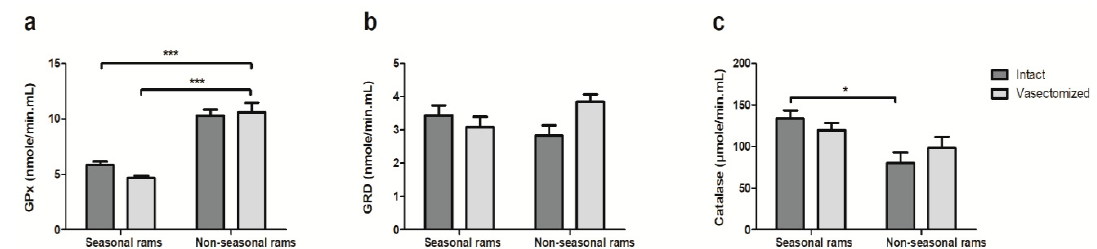
Figure 4. ( a ) Glutathione peroxidase (GPx), ( b ) glutathione reductase (GRD) and ( c ) catalase enzymatic activity in seminal plasma of intact and vasectomized rams subjected to temperate (seasonal) or equatorial (non-seasonal rams) photoperiod. Results are shown as mean ± S.E.M of n = 12 seminal plasma samples for seasonal rams, and n = 24 seminal plasma samples for non-seasonal. * p < 0.05, *** p < 0.001.